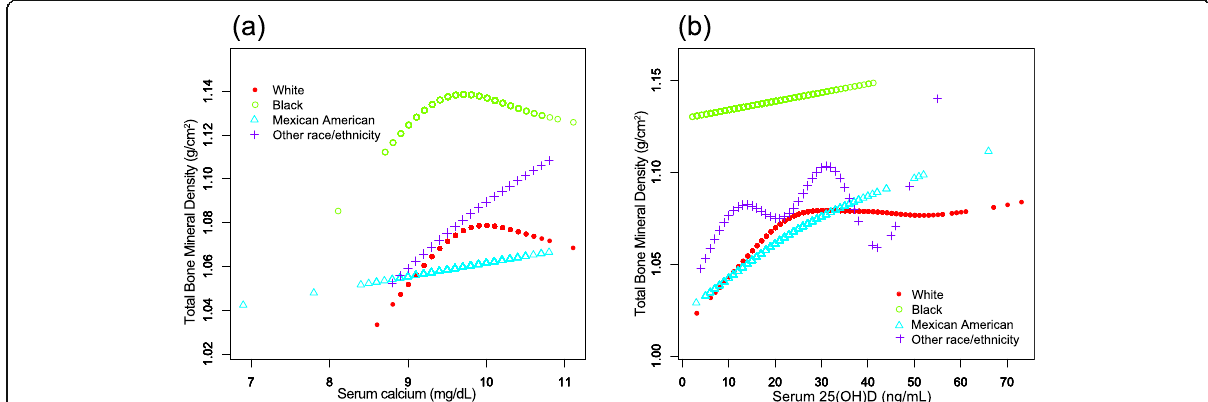
Fig. 4 The associations between serum calcium ( a ), serum 25(OH)D ( b ) and total bone mineral density stratified by race/ethnicity. Adjusted for age, gender, income to poverty ratio, education, physical activity, body mass index, calcium supplementation